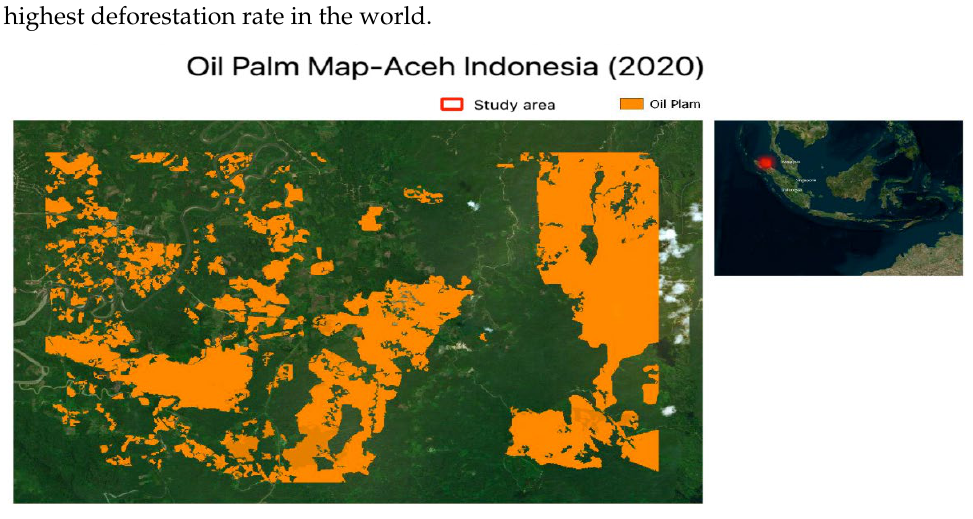
Figure 3. Study area: the state of Aceh in Indonesia .